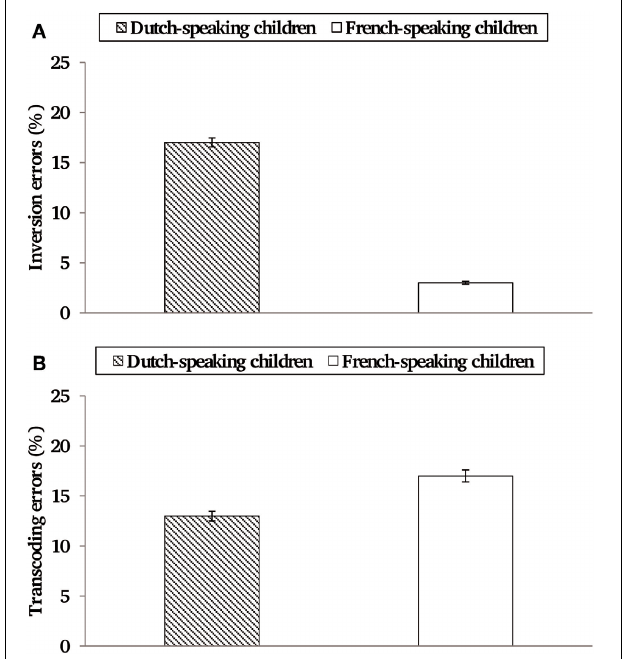
FIGURE 1 | Percentage of transcoding errors (A) and inversion errors (among the transcoding errors) (B) as a function of Language. Standard deviations were given for each